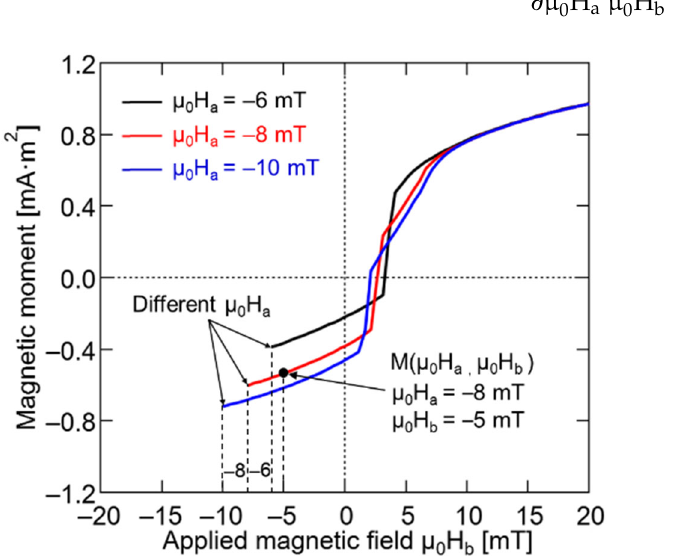
Figure 2. FORCs of Wiegand wire at various values of μ 0 H a . At the applied magnetic fields, ( μ 0 H b ) with reversal field, ( μ 0 H a ), black point of magnetization on FORC can be represented using M ( μ 0 H a = − 8 mT, μ 0 H b = − 5 mT). ( µ − 8 mT, µ − 5 0 H a = 0 H b =